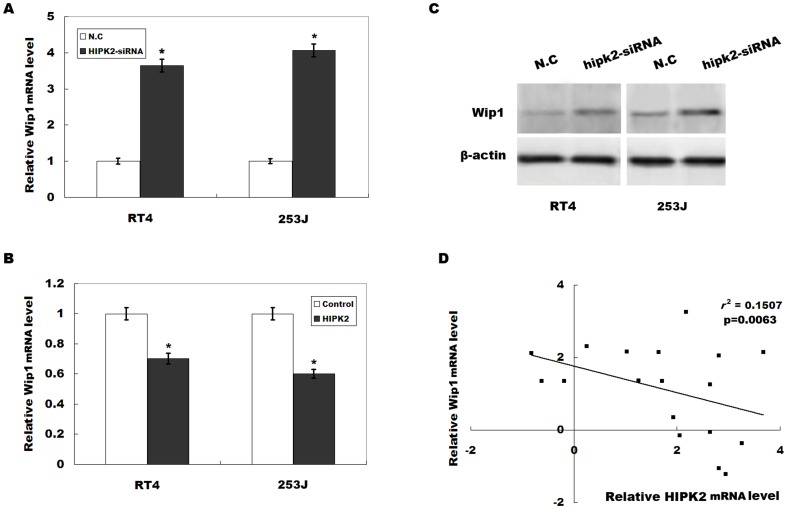
HIPK2 negatively regulates Wip1 expression.(A) Wip1 mRNA levels were evaluated by real-time PCR after HIPK2 inhibition in RT4 cells and 253J cells. *p<0.05. (B) Relative Wip1 mRNA level after HIPK2 overexpression in RT4 cells and 253J cells. *p<0.05. (C) Western blot analysis of Wip1 level after HIPK2 inhibition in RT4 and 253J cells. (D) Negative correlation between the HIPK2 levels and the Wip1 levels in 18 patients with bladder cancer after cisplatin-based combination chemotherapy (r
2 = 0.1507, p = 0.0063). Relative Wip1 or HIPK2 expression was calculated and normalized with respect to β-actin mRNA. All data were expressed as fold change relative to a tissue (control, expression = 1).